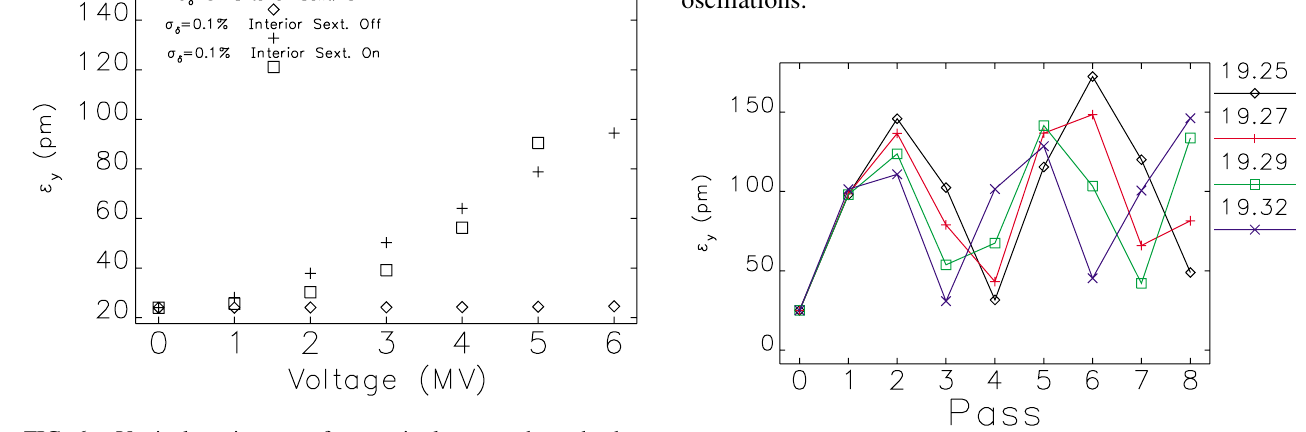
off.FIG. 6. Vertical emittance after a single pass through the system as a function of deflecting voltage for h (cid:3) 8 . With interior sextupoles off, tracking with and without momentum spread illustrates the impact of the natural